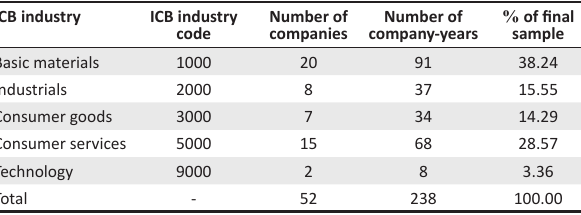
TABLE 2: Sample composition.